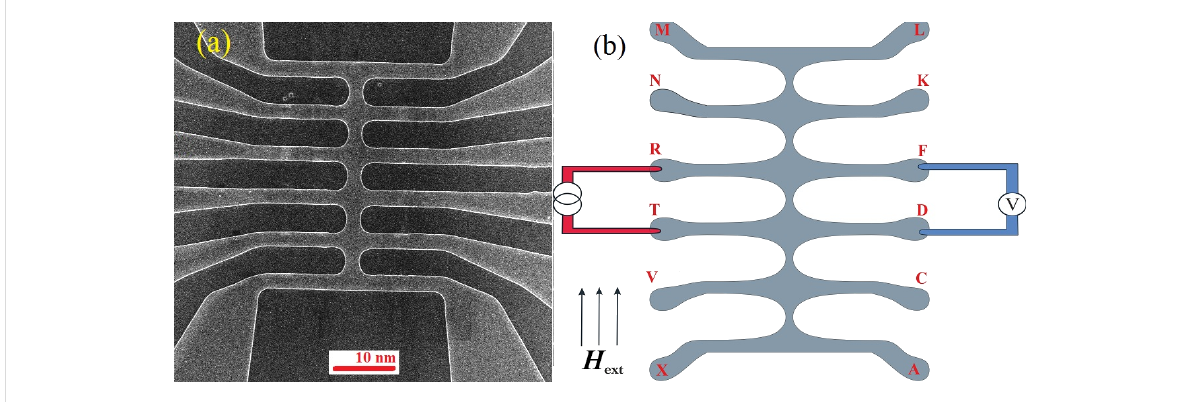
Figure 4: A micrograph (a) and a principal scheme (b) of the structure used for the critical temperature measurements (each contact was marked with a letter).